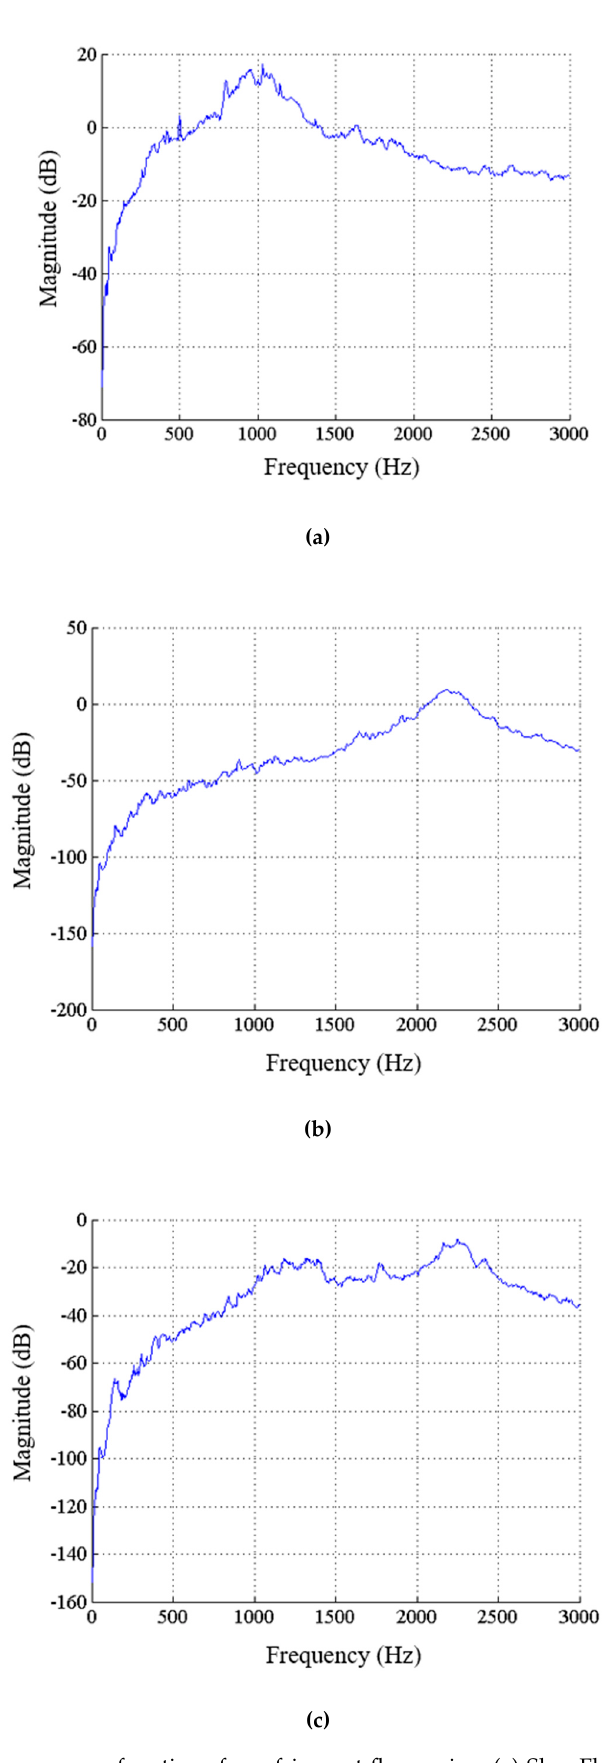
Figure 7. Frequency response functions for refrigerant flow noise: ( a ) Slug Flow, ( b ) Churn Flow, ( c ) Annular